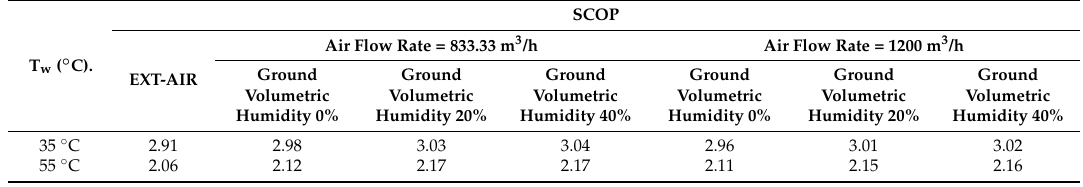
Table 9. SCOP values with and without the use of geothermal probe (H = 3 m, L = 30 m, d = 0.5 m).